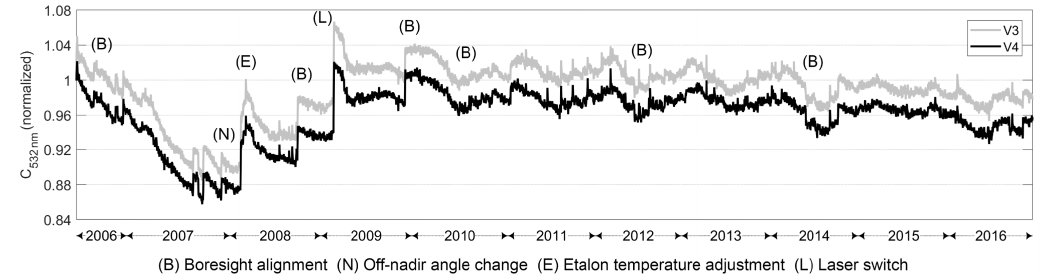
Figure 8. Time series of the granule-averaged V3 and V4 532nm CALIOP nighttime parallel channel calibration coefficient, smoothed over 10 consecutive granules. The values have been normalized by 6 . 1483 × 10 10 km 3 srJ − 1 count. Letters indicate a subset of most significant instrument events that affect the calibration: (B) – boresight alignment; (E) – etalon temperature adjustment; (L) – laser switch; and (N) – off-nadir angle change. Not all events are marked.